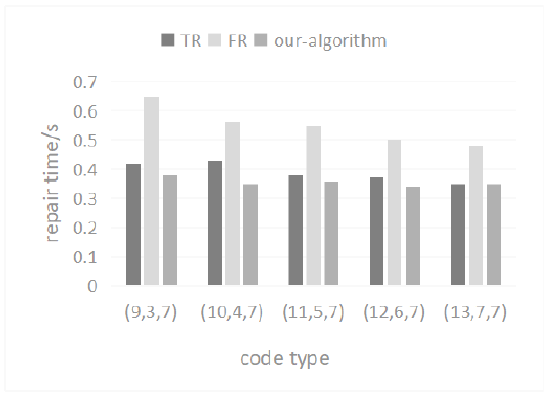
Figure 12. Under different erasure code sizes, the topological repair delay distribution diagram constructed by SR, TR, and our algorithm.